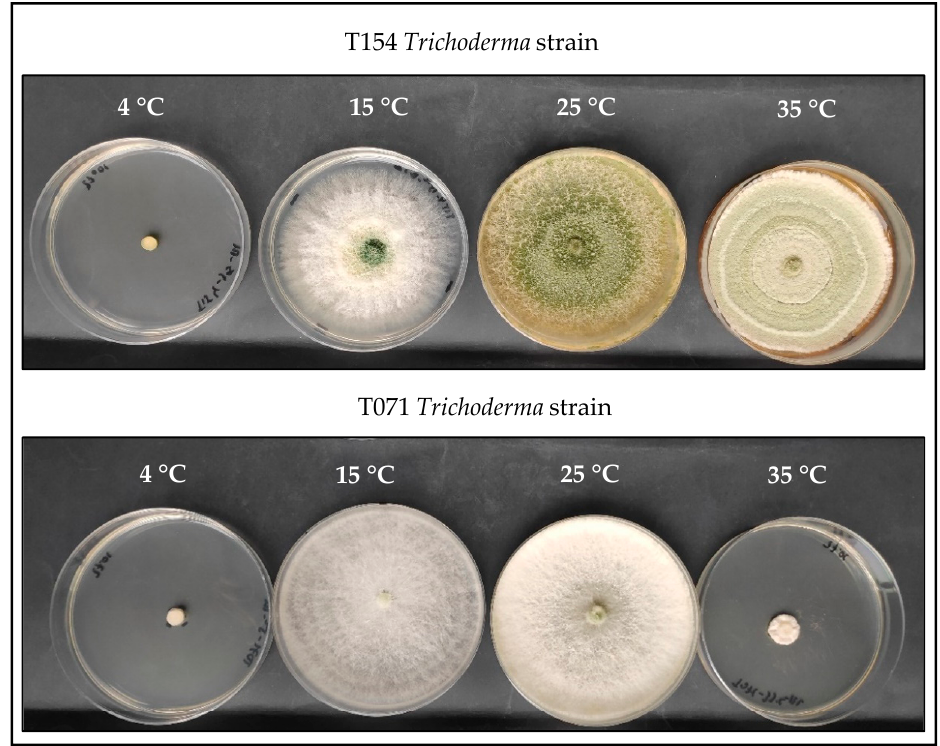
Figure 1. Growth of the Trichoderma strains T154 and T071 after 7 days at 4 °C, 15 °C, 25 °C, and 35 °C.